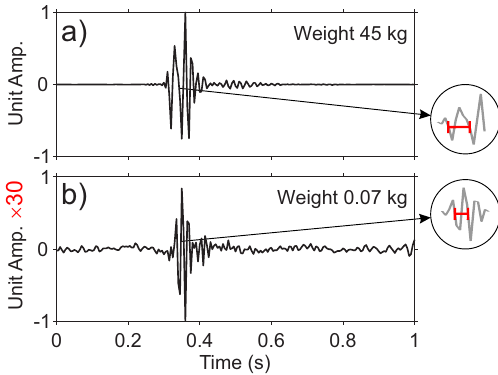
Figure 1. Rock drop experiment on a dry gravel-bed channel in the French Alps, Pré de Madame Carle (Burtin et al., 2011). Parti- cles with a weight of 45kg (a) and 0.07kg (b) fall from a height of 1m. The ground vibrations are recorded by a seismometer at a distance of 7m from the impact. Amplitude is normalized for each drop but the 45kg particle has a seismic signal 30 times larger than the 0.07kg one. A longer wavelength is also observed on the seis- mic signal from the heaviest